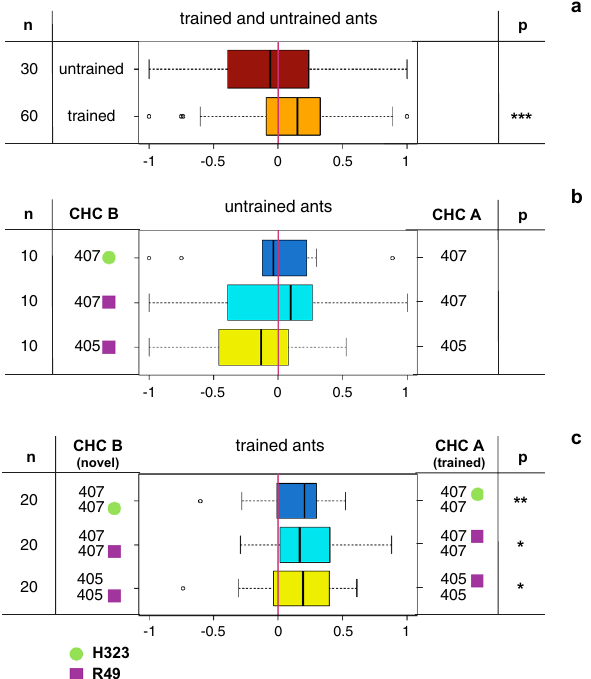
Figure 3. Preference indices (PI) of ant behavioral experiments. A PI of zero means no preference, a PI above or below zero a preference for CHC A (trained), or CHC B (novel), respectively. The number of replicates is indicated by n. Green dots represent an infection with H. defensa strain H323 and purple dots an infection with R. insecticola strain R49. ( a ) Shows a global plot of trained versus untrained ants. ( b ) Shows the absence of preferences of untrained ants. ( c ) Shows the preference of trained ants. Half of them were trained to the CHCs of uninfected aphids, the other half to CHCs of infected aphids. Asterisks show significant differences from zero ( P value, * < 0.05, ** < 0.005, *** < 0.0005). Exact P values are mentioned in the